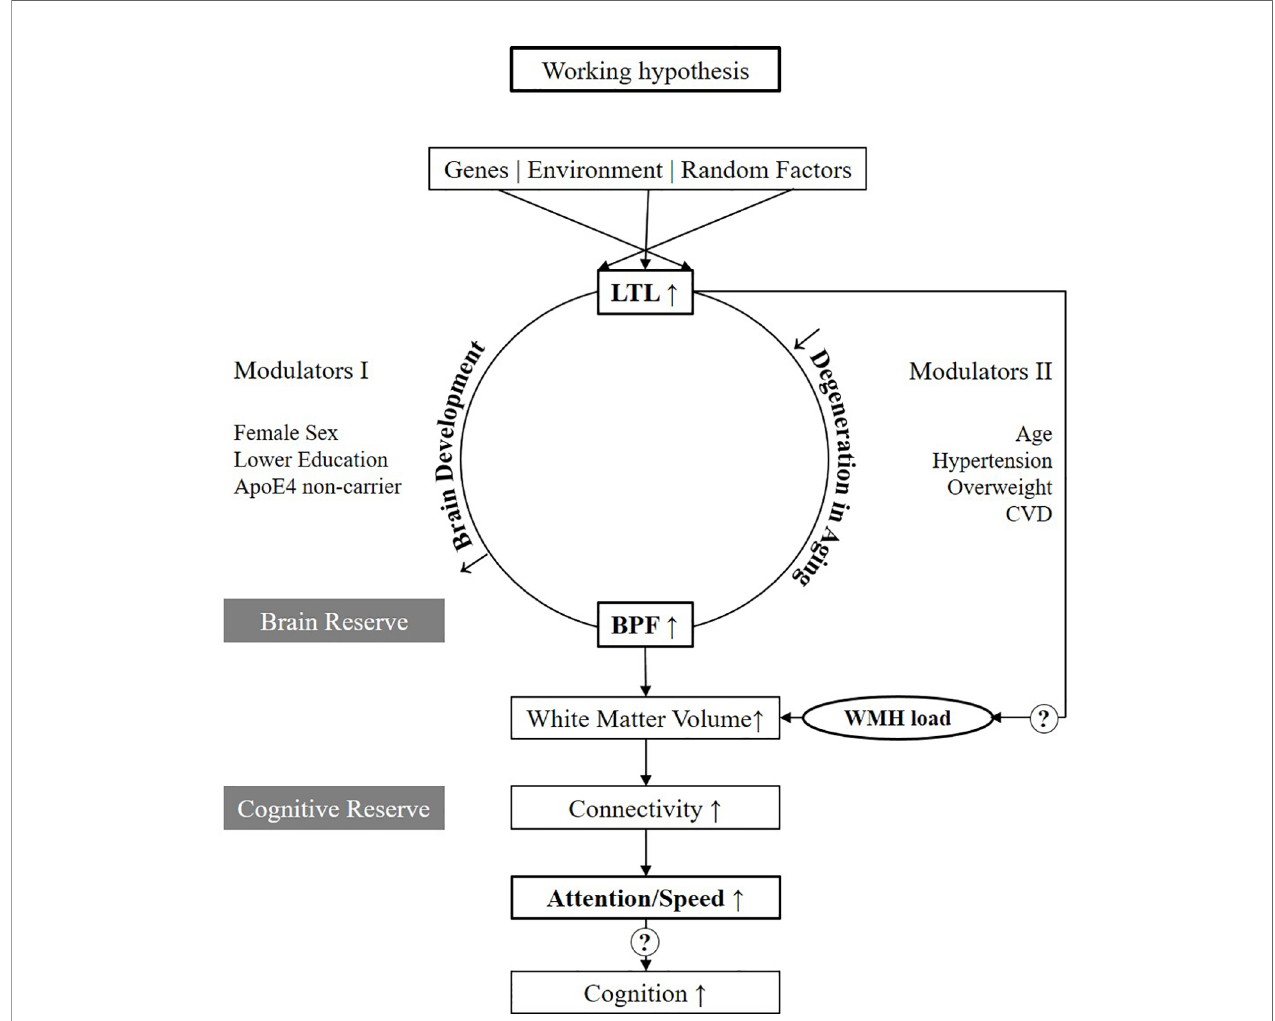
FIGURE 3 | Working hypothesis. Variables in bold are those which are tested in the present study. LTL, Leukocyte Telomere Length; BPF, Brain Parenchymal Fraction; WMH, White Matter Hyperintensities; CVD, Cardiovascular